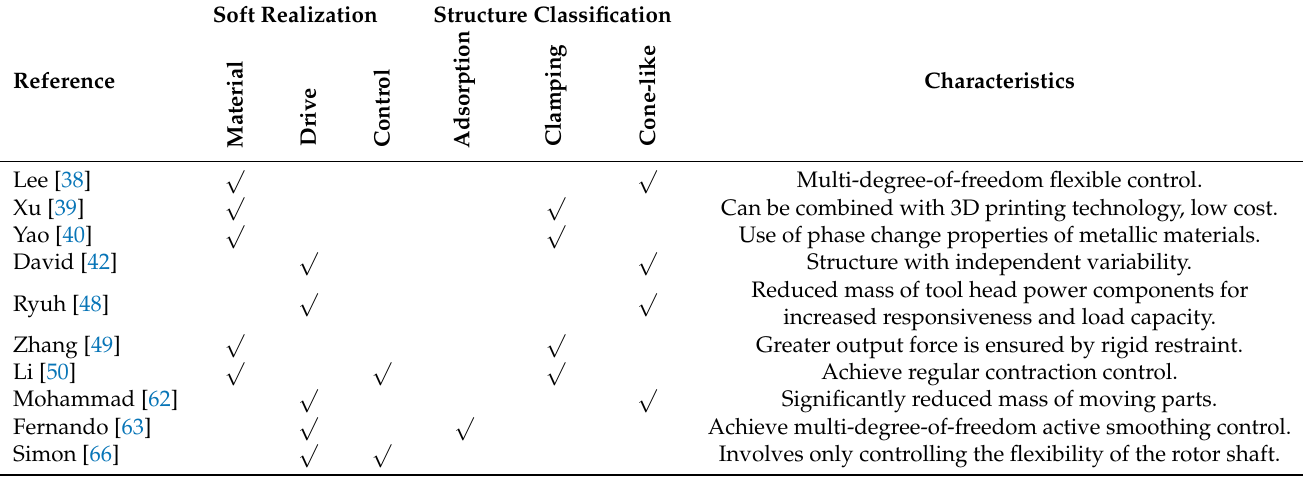
Table 1. Summary of innovative structural design results of impedance control actuators. Soft Realization Structure Classification Reference